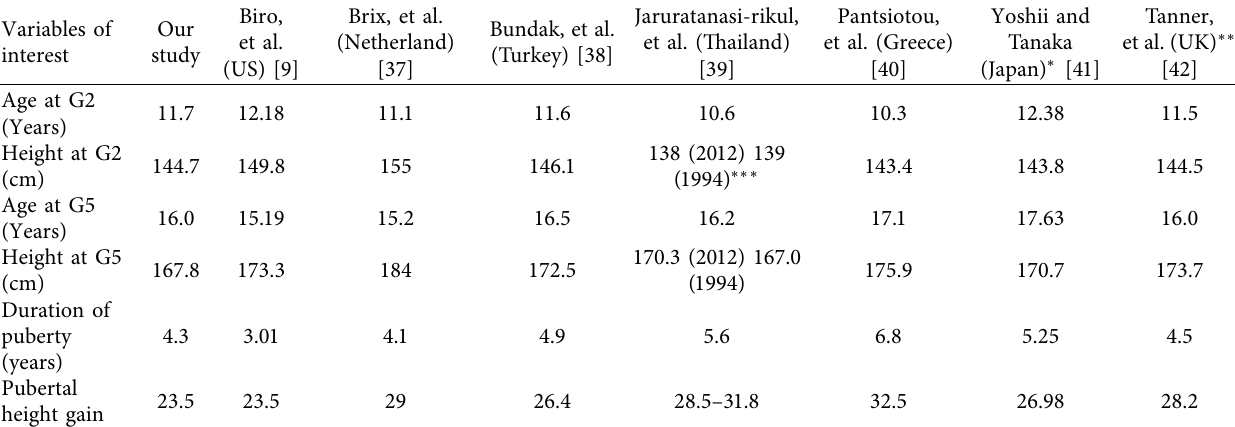
Table 4: Mean age of pubertal maturation and mean pubertal height gain (in cm) in pubertal studies of different populations. Variables of